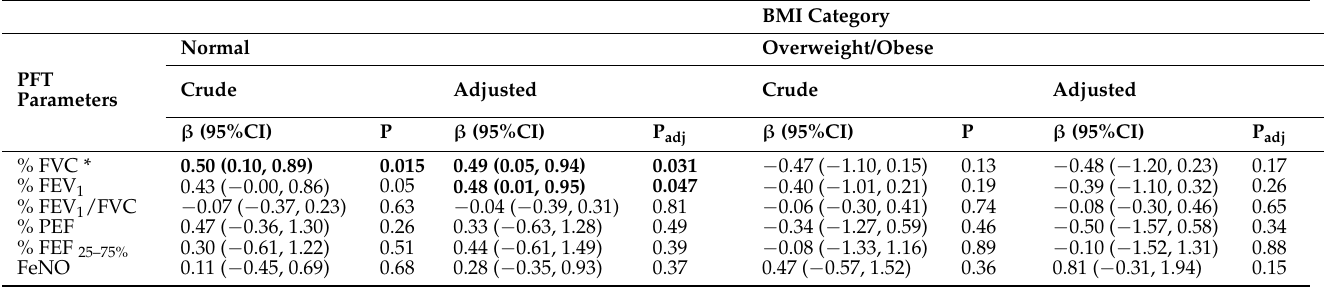
Table 3. Associations between vitamin D and pulmonary function tests by BMI category from the crude and adjusted linear regression